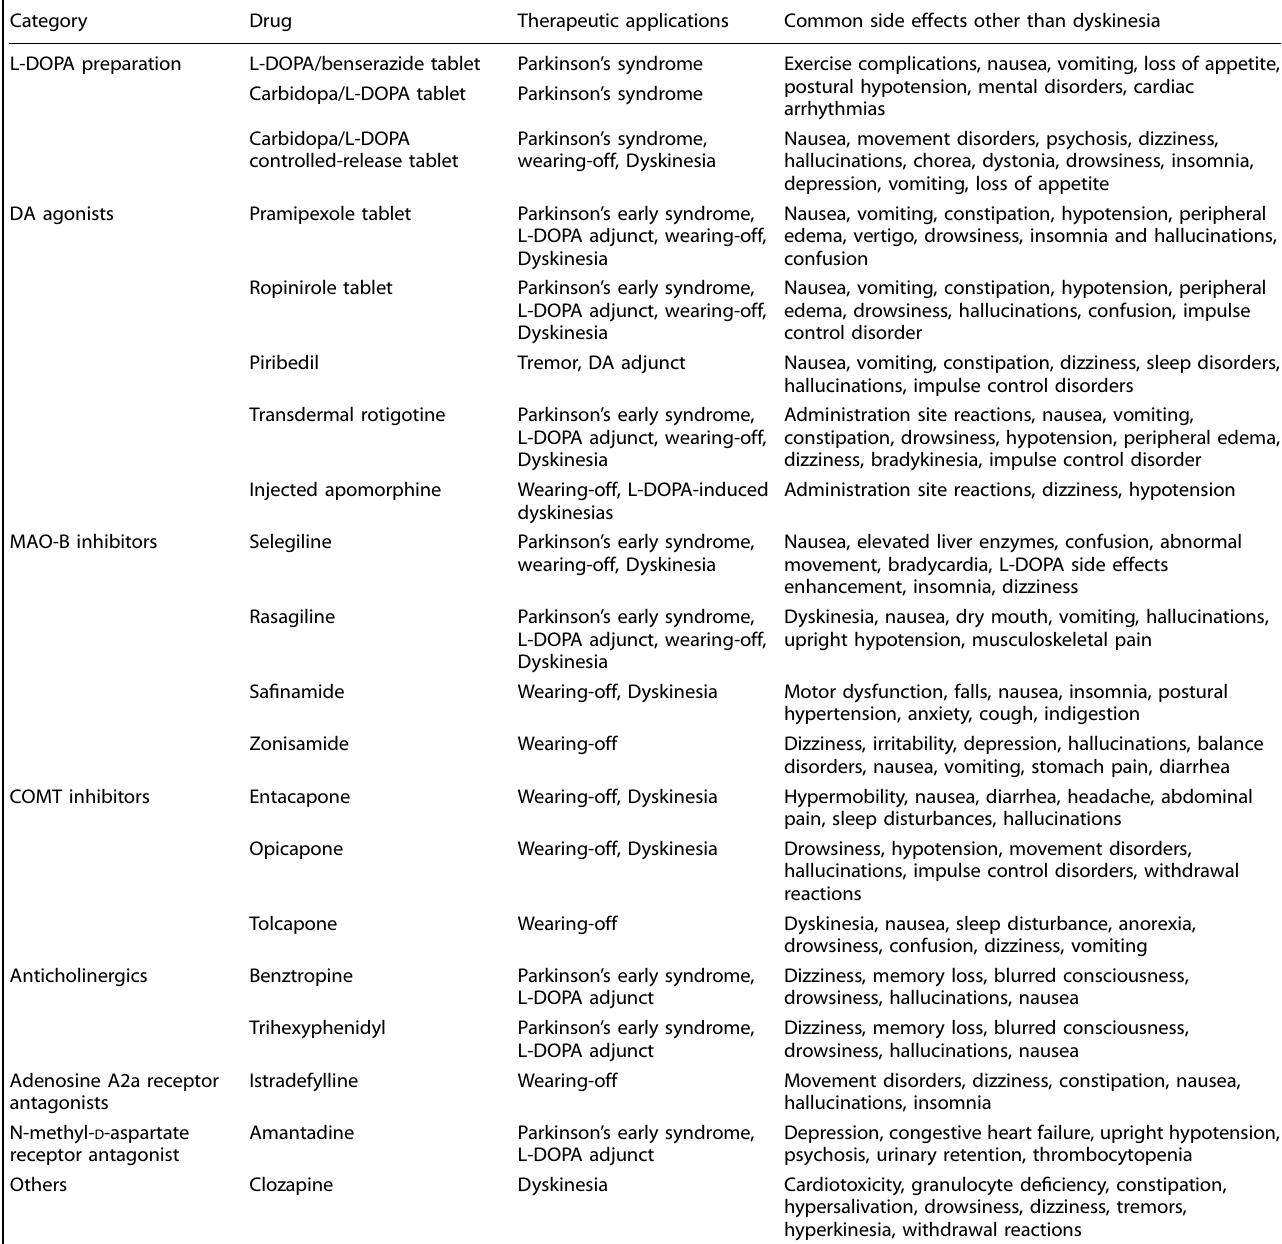
Table 1. Commercially available drugs for PD treatment